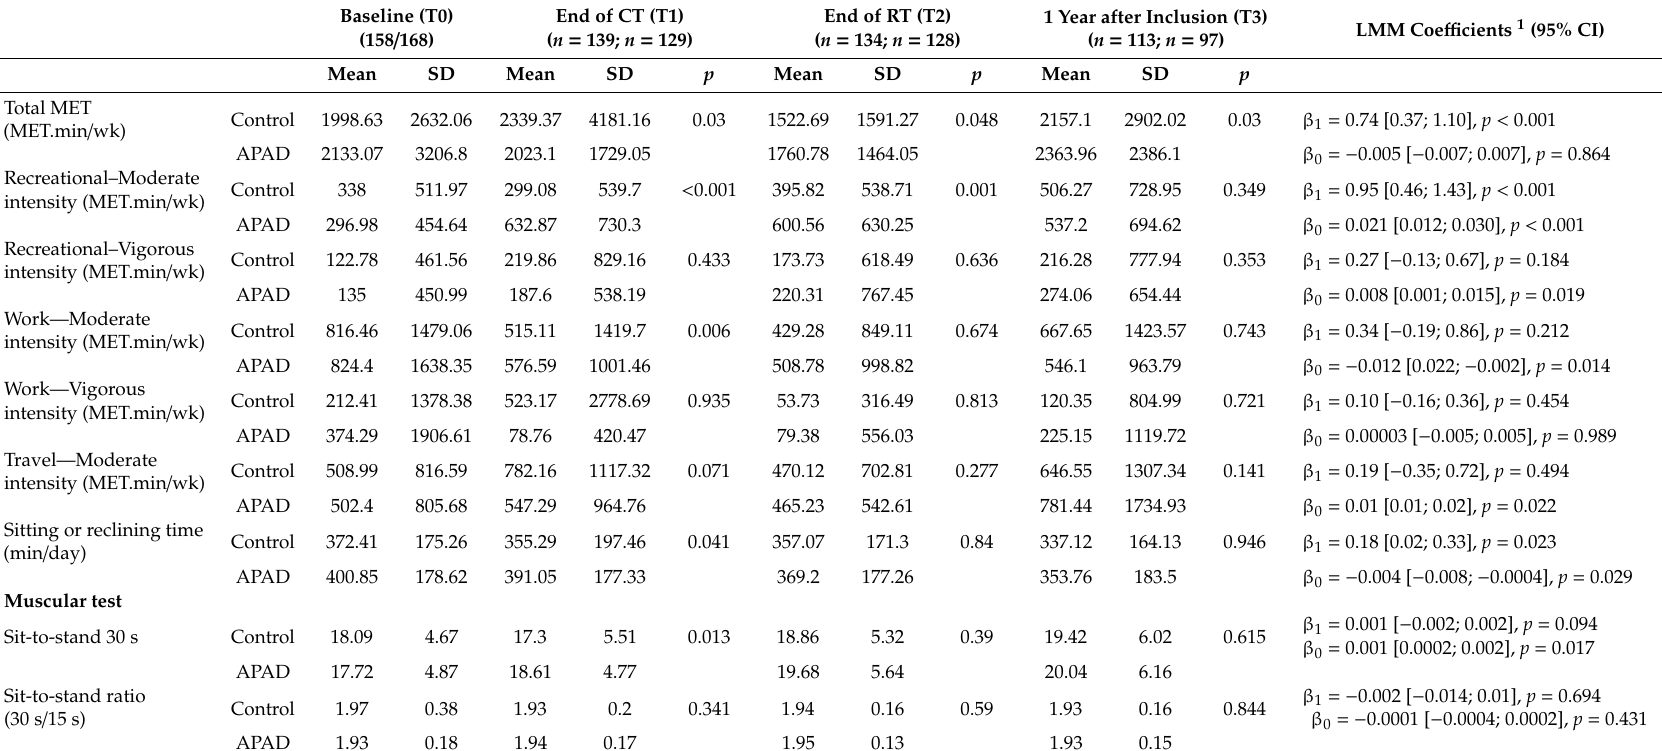
Table 4. Physical activity according to the GPAQ and muscular test in the intention-to-treat